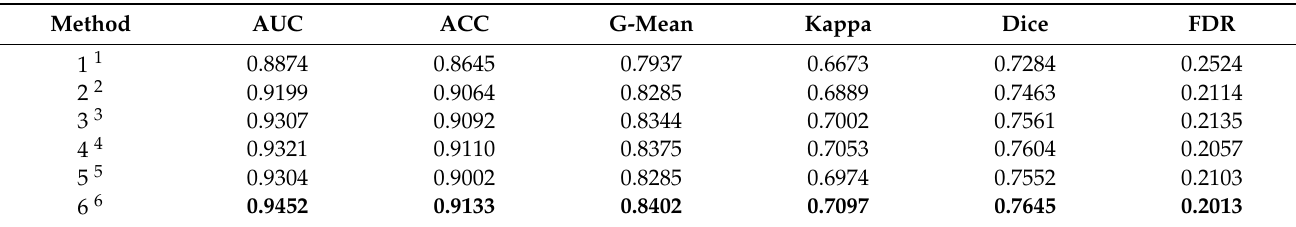
Table 7. Ablation experiment on